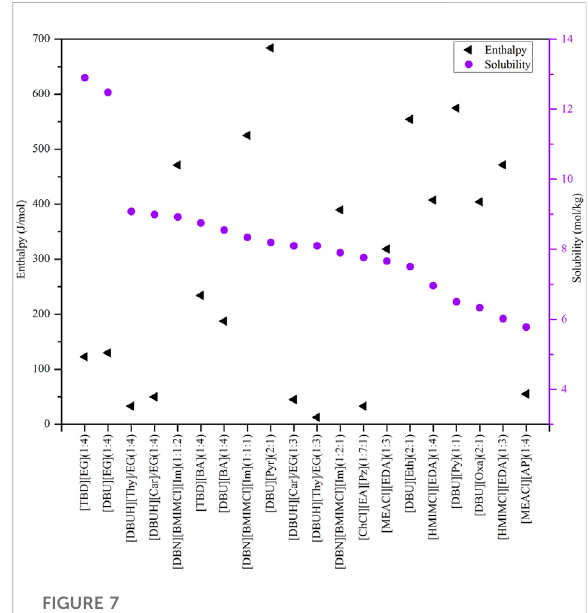
FIGURE 7 Top 20 chemical-based DESs based on their